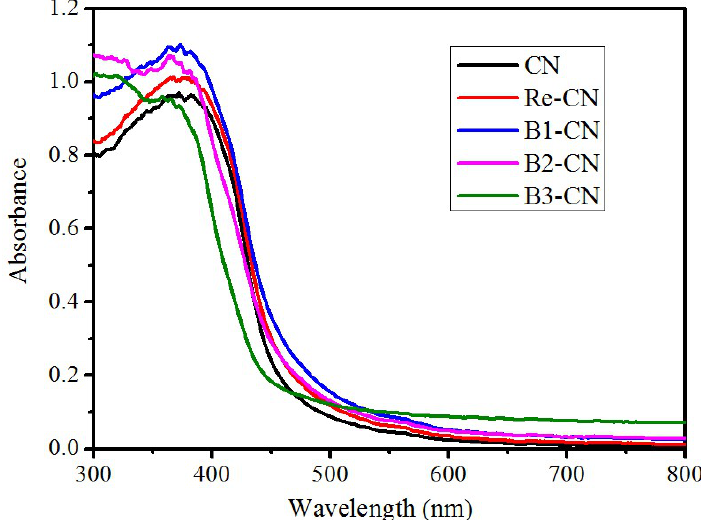
Figure 5. Diffuse reflectance spectra of CN, Re-CN, and CN/B 2 O 3 series composite materials.